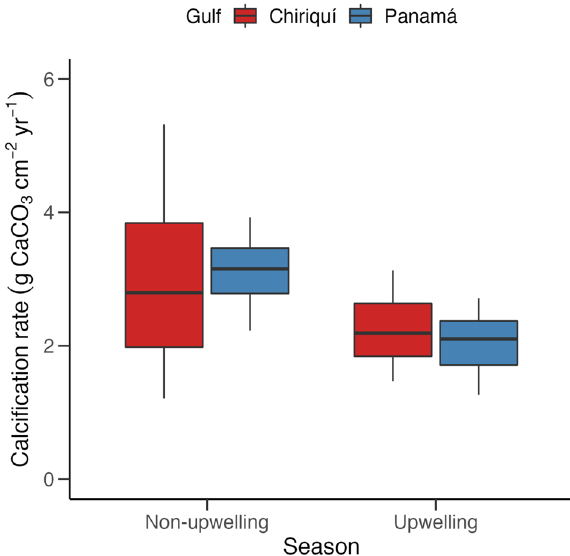
Figure 2. Boxplot of median (± interquartile range) Pocillopora calcification rate (g CaCO 3 cm −2 year −1 ) for each gulf across the upwelling and non-upwelling seasons of Pacific Panamá from 2016 to 2018. The upwelling season runs from March through September, and the non-upwelling season runs from October through February.